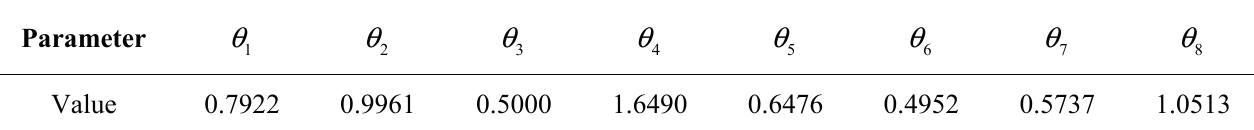
Table 3. Parameters of the surrogate